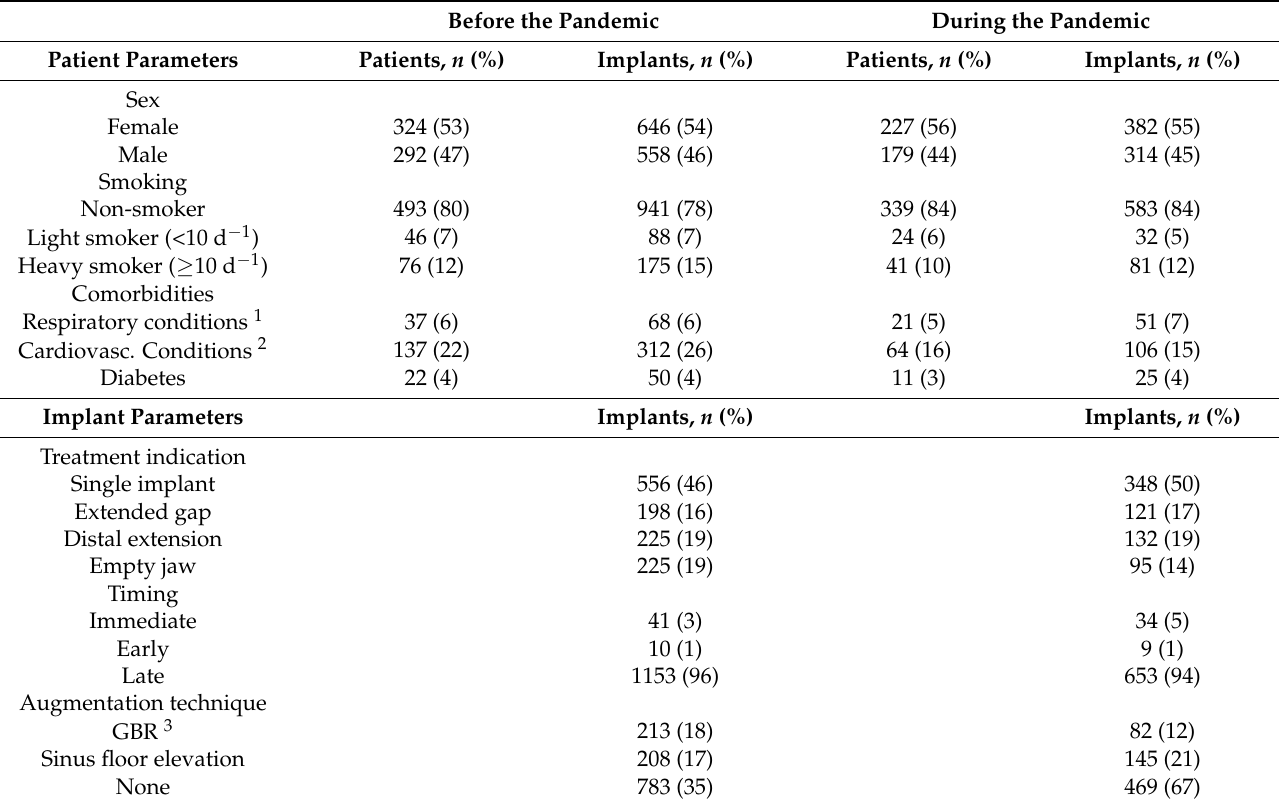
Table 1. Subject and implant